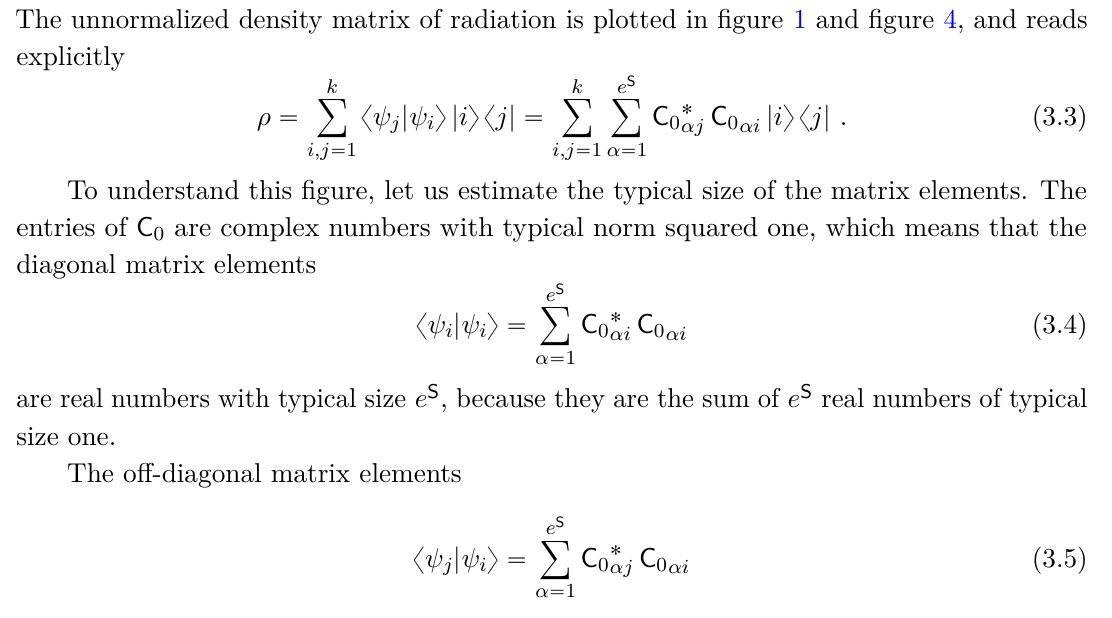
Figure 4 . Normalized density matrix with k negative. The diagonal is removed (right) and the intensity is rescaled to probe typical sizes 1 This reproduces similar plots obtained within SYK, with notably a different realization for the density matrix than (3.3)